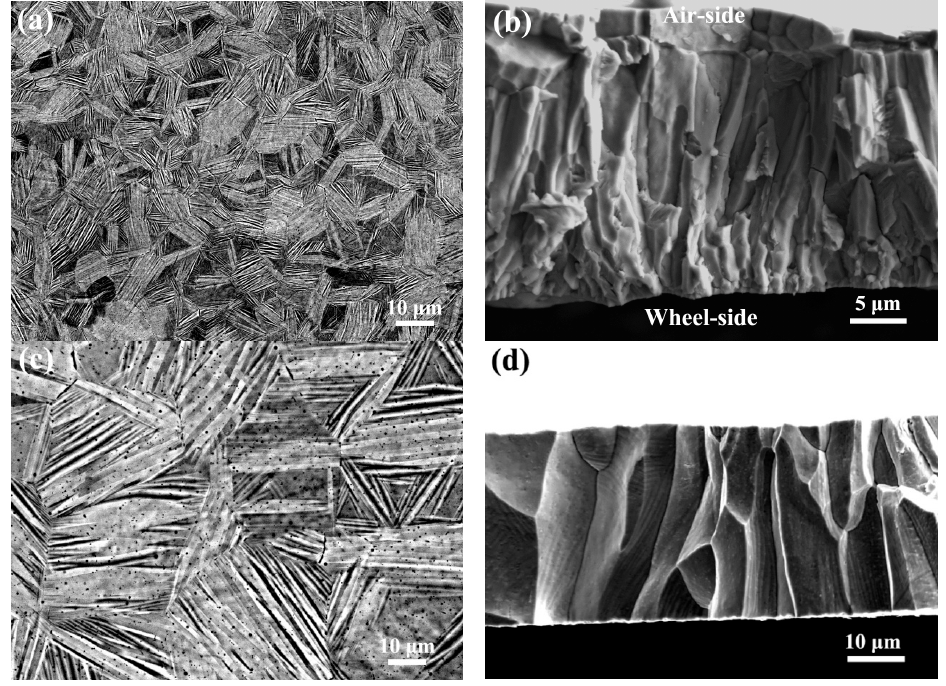
Figure 3. ( a ) Backscattered electron (BSE) image of the ribbon plane for melt-spun ribbons; ( b ) Secondary electron (SE) image of cross-section for melt-spun ribbons; ( c ) BSE image of ribbon plane for annealed ribbons; ( d ) SE image of cross-section for annealed